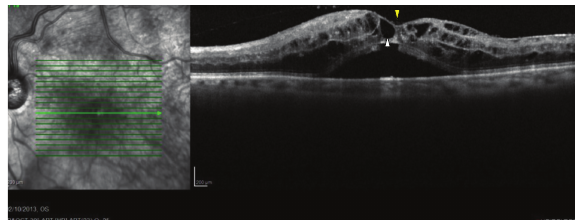
Figure 7: Macular edema in a 75-year-old woman with CRVO. There are several cystic spaces in the retinal layers (white arrow- head), although the foveal depression is preserved (yellow arrow-